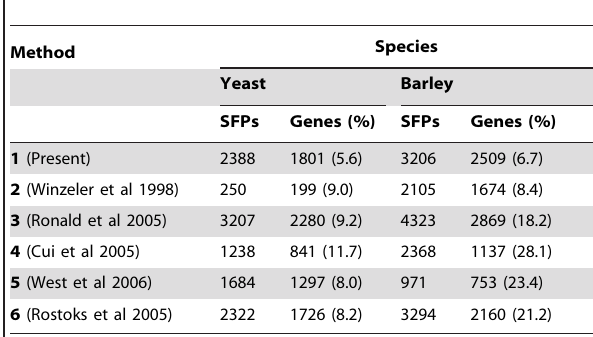
Table 2. The numbers of SFPs and SFP-bearing genes called by the six different methods from the yeast and barley gene expression